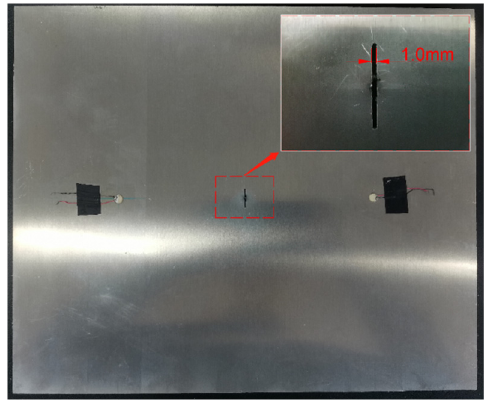
Figure 16. The diagram of crack width at 15 mm crack length.